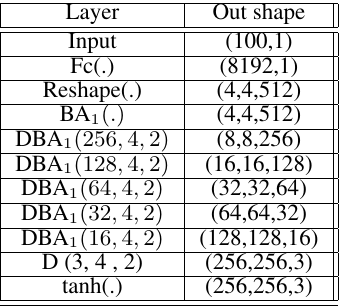
Table 2. Architecture of the Generator for the three